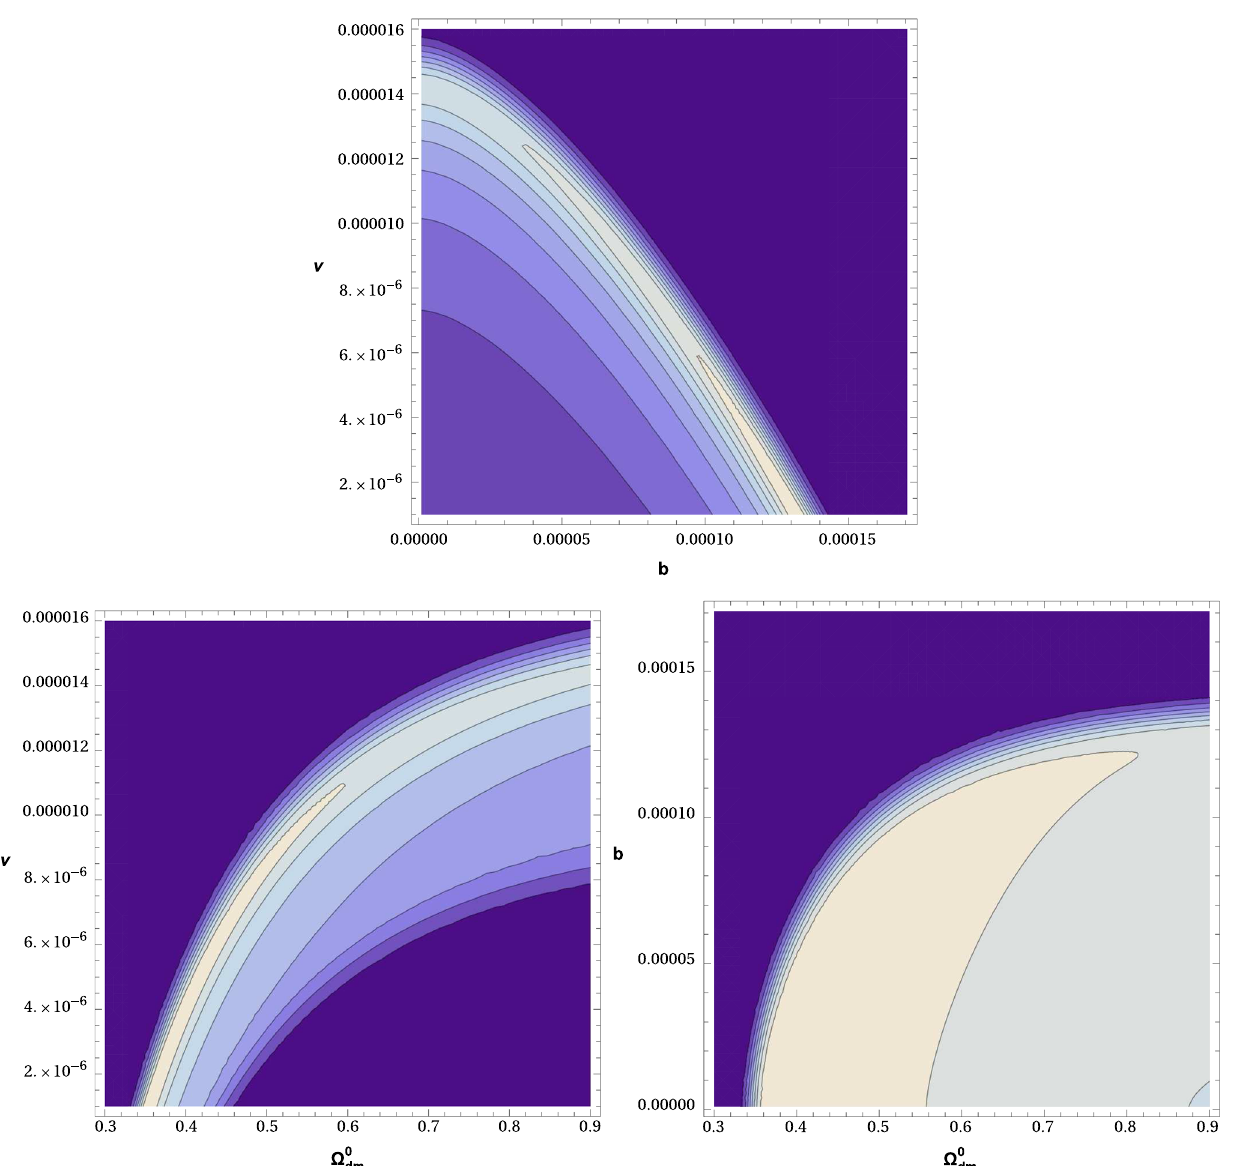
Fig. 4 Two-dimensional probability distribution for the observational test using the first CMB acoustic peak. The brighter regions have higher probabilities